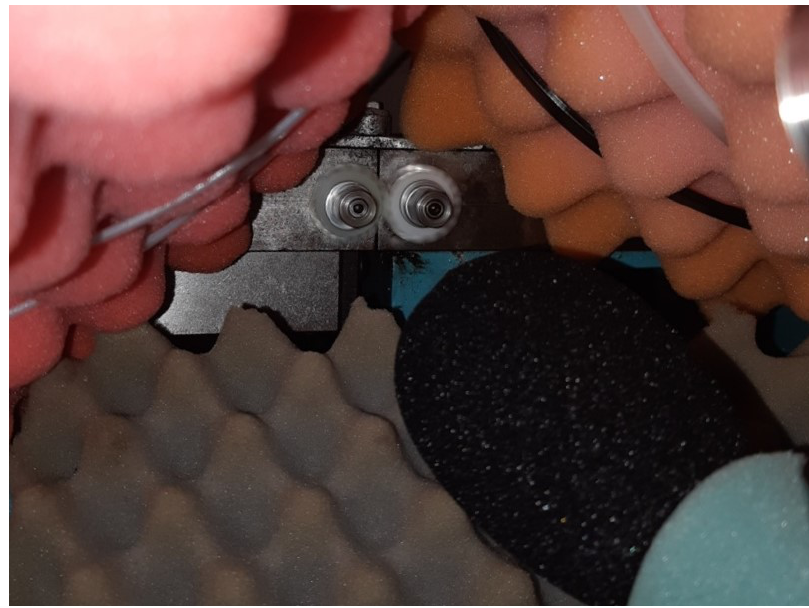
Figure 4. The operated gear pair on the testing device with the soundproof acoustic foam for acoustic soundproof insulation.